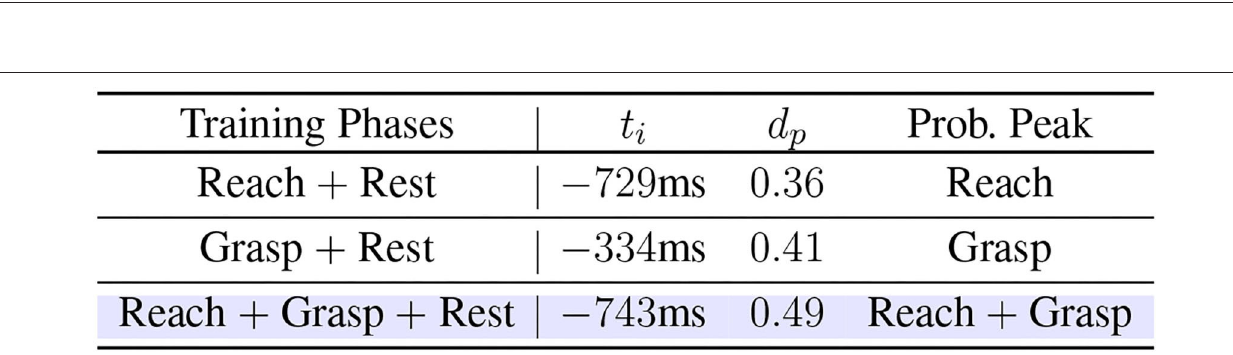
FIGURE 10 | The summary of model performances trained by the first, second, and third training